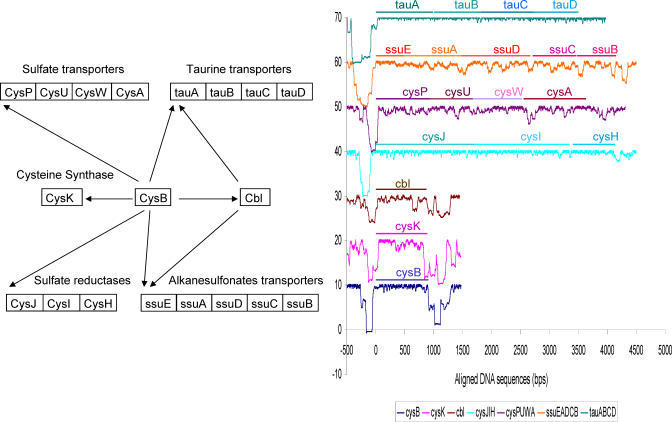
SIDD Profiles of the Genomic Regions Containing Genes (Operons) in the CysB Regulatory PathwayThe left panel shows a diagram for CysB regulatory pathway, according to the information provided in [54]. The right panel shows the SIDD profiles for the operons encoding the genes for the proteins in the CysB regulatory pathway. These profiles are aligned at their translation start sites.